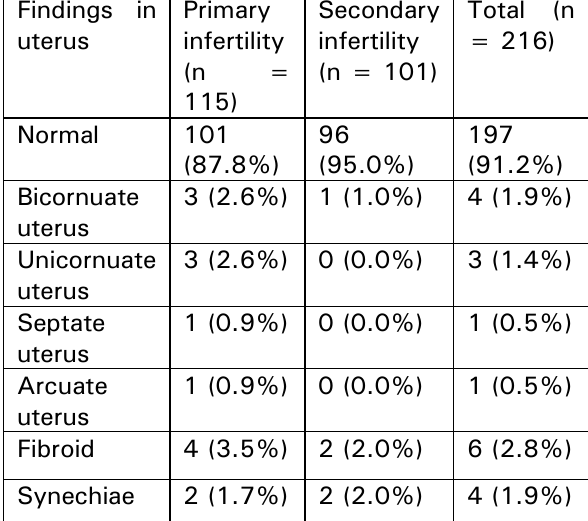
Table 3: Distribution of uterine findings in